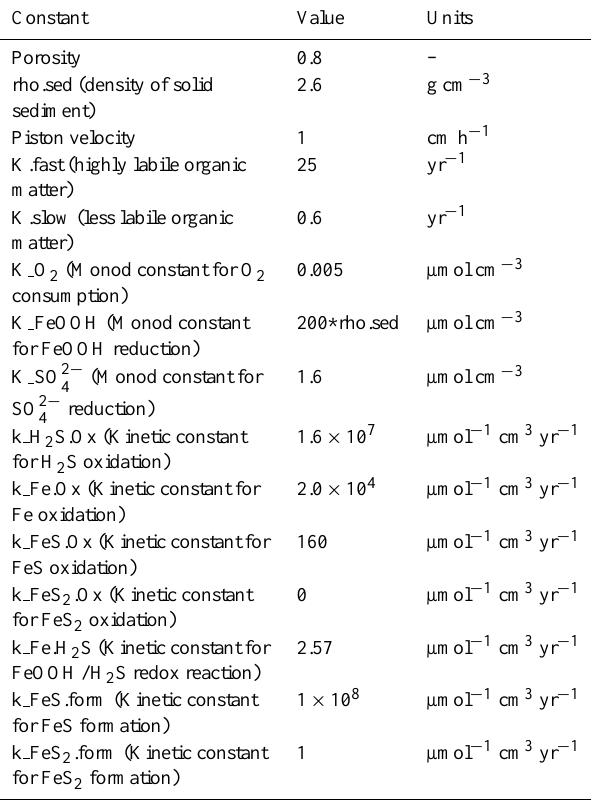
Table 3. Overview of model parameter values.